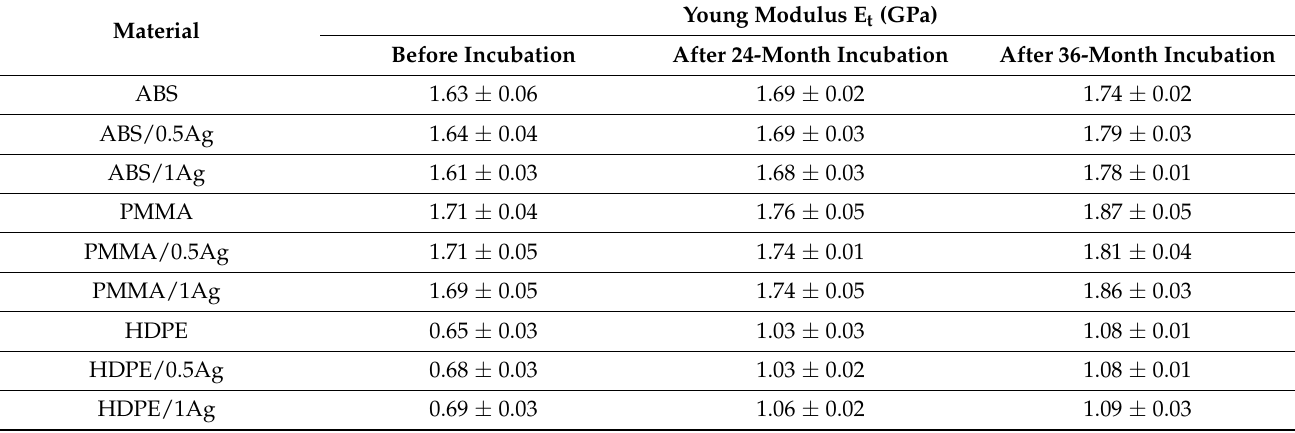
Table 3. Results of the Young’s modulus of polymers and composites modified with 0.5 wt.% and 1.0 wt.% AgNPs.